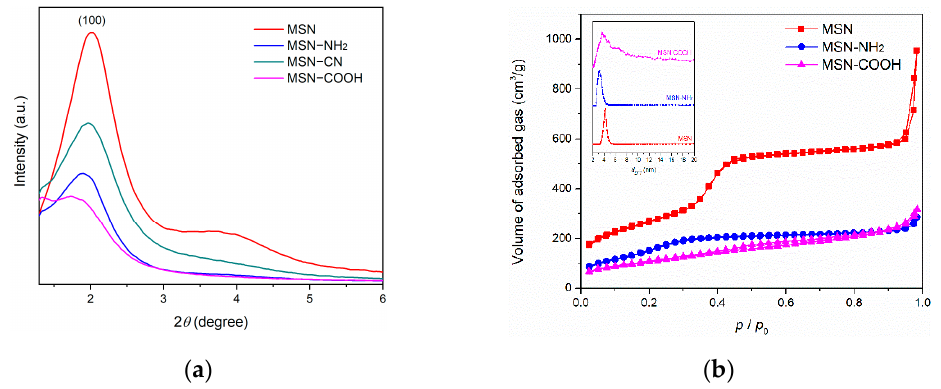
Figure 1. Small-angle XRD patterns ( a ) and nitrogen adsorption/desorption isotherms with pore size distribution in the inset ( b ) of MSN carriers.